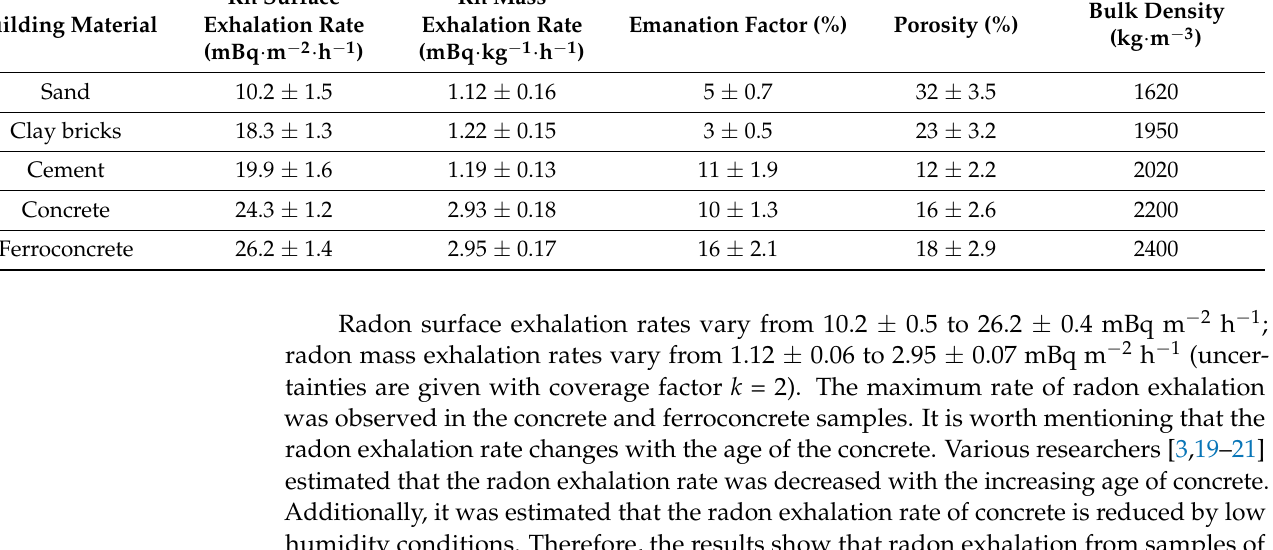
radon exhalation rate changes with the age of the concrete. Various researchers [3,19–21] estimated that the radon exhalation rate was decreased with the increasing age of concrete. Additionally, it was estimated that the radon exhalation rate of concrete is reduced by low humidity conditions. Therefore, the results show that radon exhalation from samples of concrete measurements is dependent on the humidity and age of the sample and should be standardized. Radon surface exhalation and mass exhalation rates found for sand are the lowest values and for concrete and ferroconcrete are found to be the maximum. The emanation fraction varies from 5 to 16%. The results obtained in this work are within the values measured in other countries [18,22–25]. Correlation analysis showed a strong positive correlation (0.88) between radon concentration and radium activity concentration in various samples, which may be due to the radium content and porosity in the samples (Figure 1).